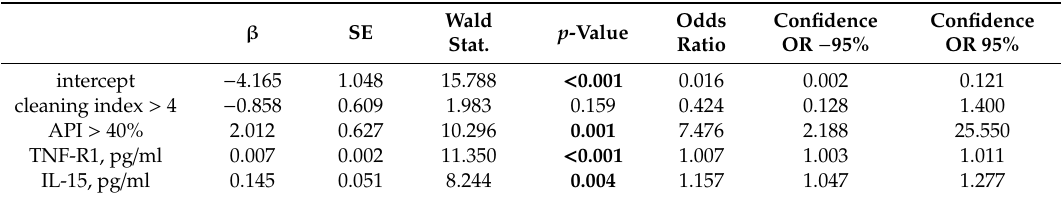
Table 5. Parameters of predictors incorporated into the multivariate logistic regression model, including brushing frequency per day.